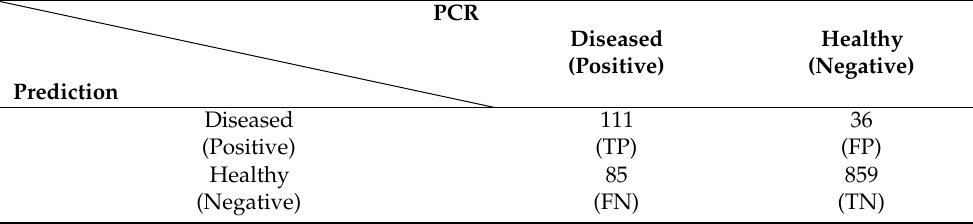
Table 1. Confusion matrix. Polymerase chain reaction labeling and optical prediction results for the testing group ( n =